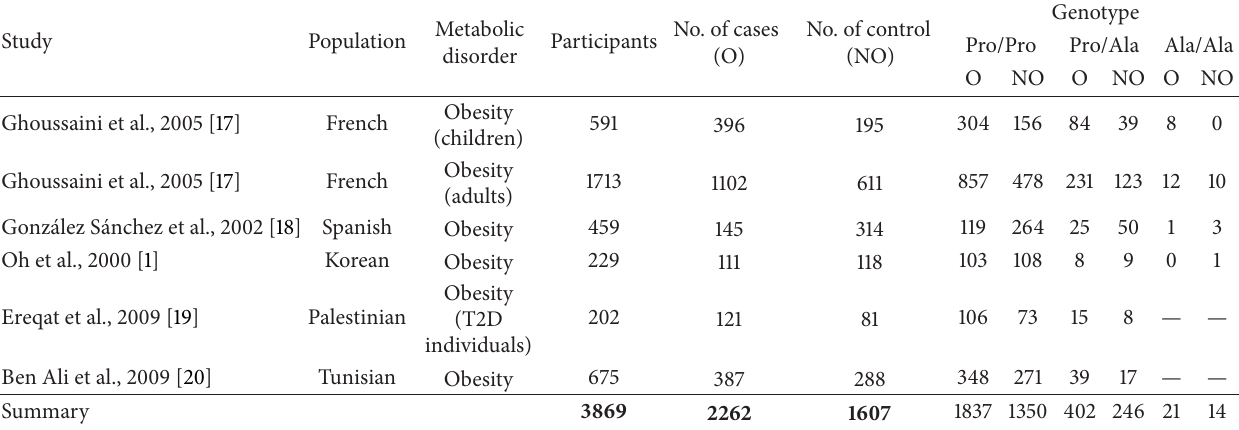
Table 1: Included studies in the meta-analysis for obesity and respective genotype of the studied population.